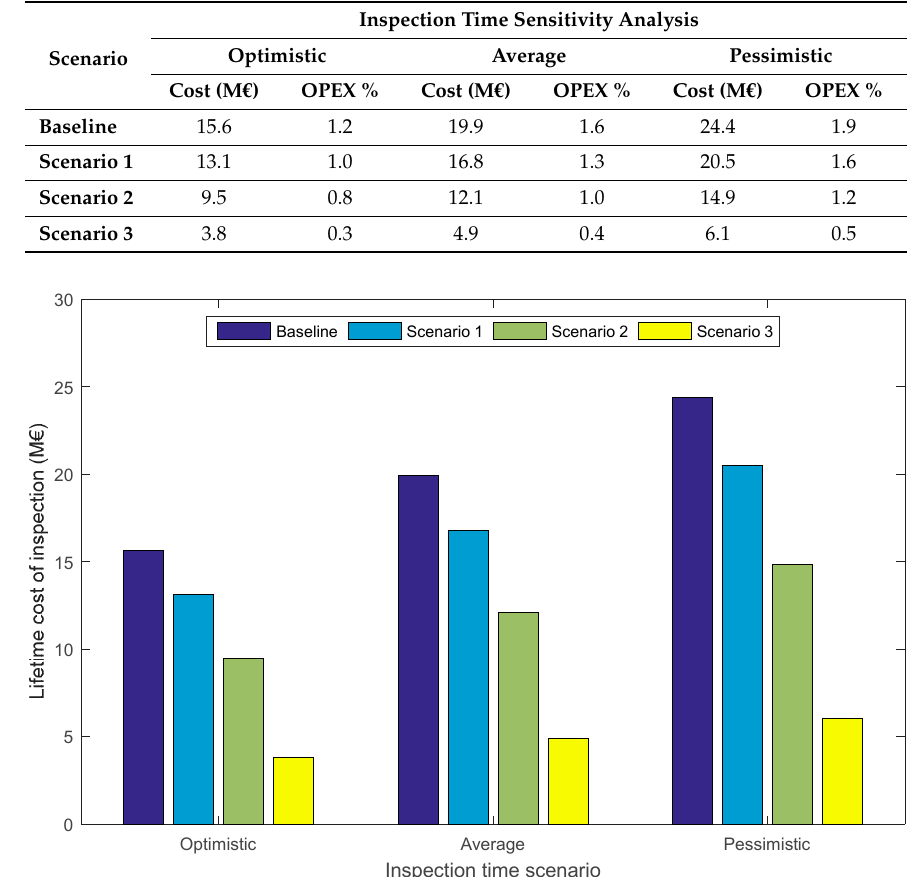
Figure 5. Graphical comparison of lifetime cost of structural inspections under different scenarios.